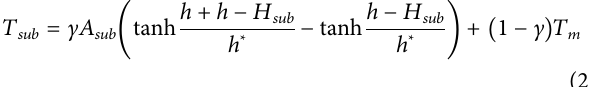
Frontiers in Earth Science |